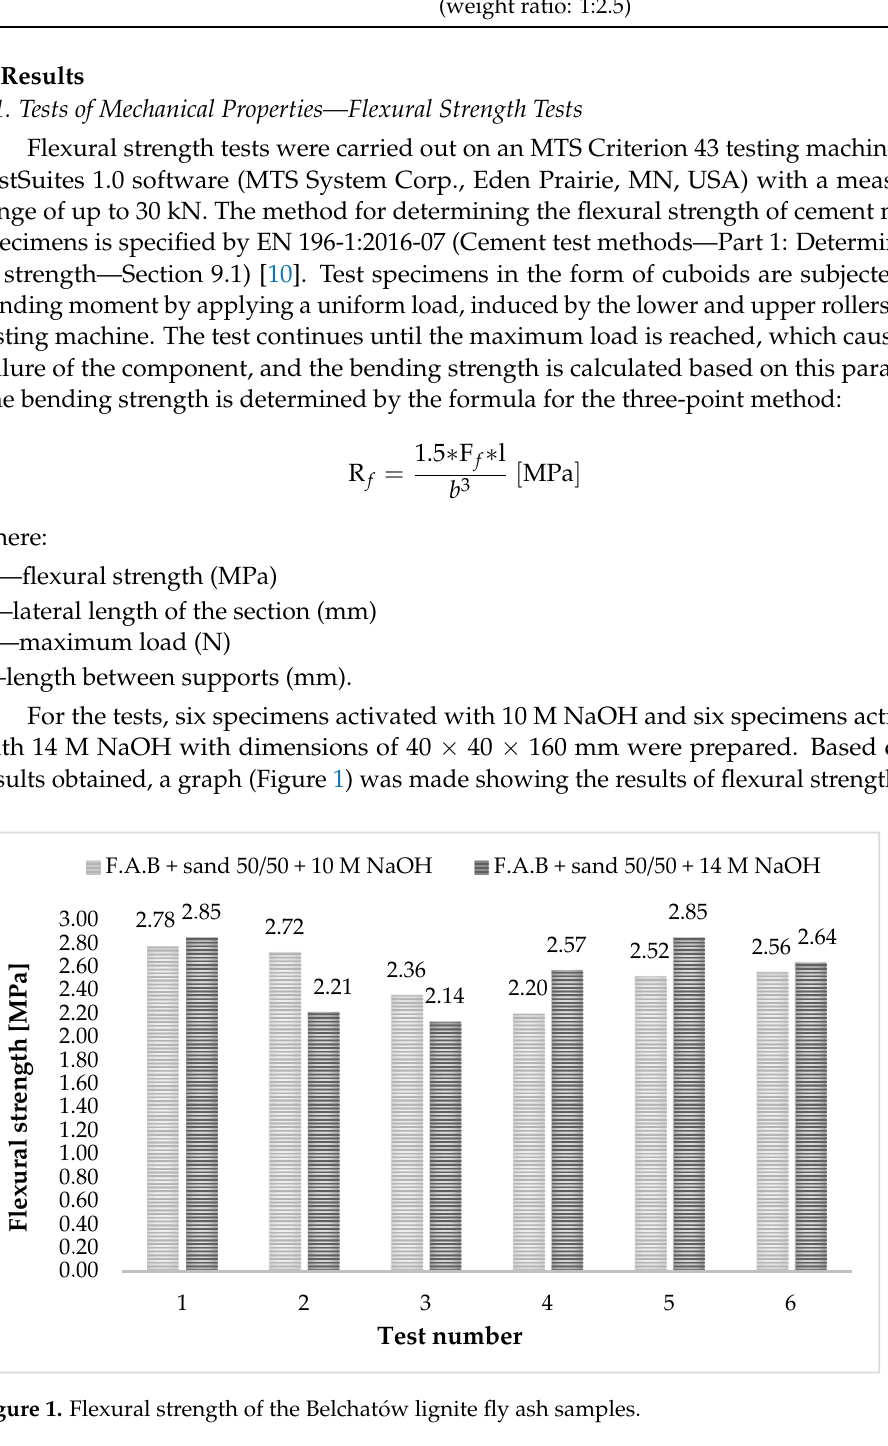
Figure 1. Flexural strength of the Belchatów lignite fly ash samples.